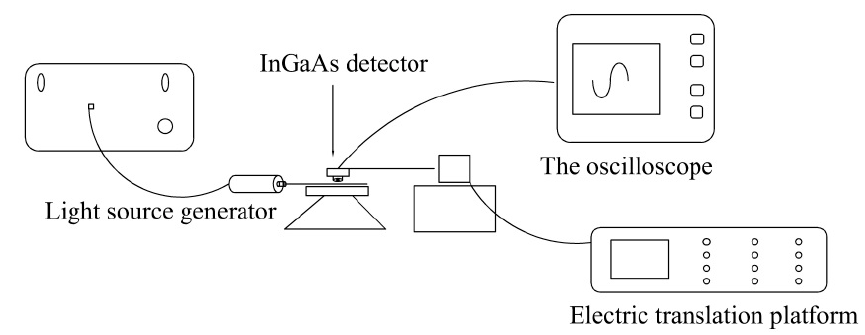
Figure 2. Illumination intensity test system.